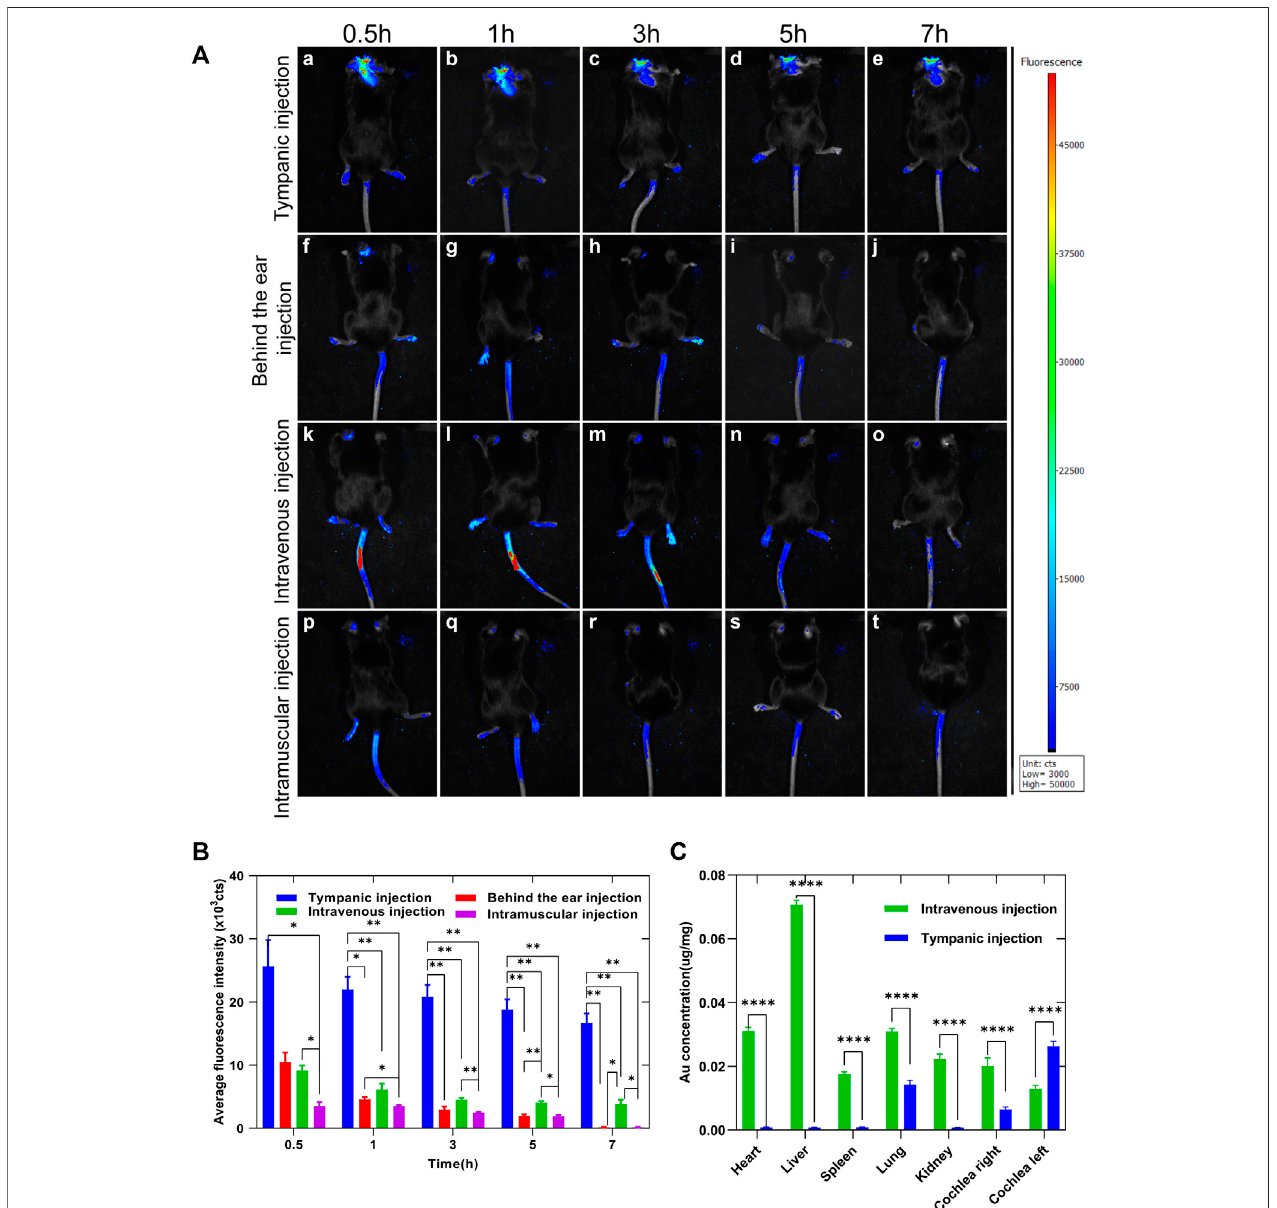
FIGURE 6 | (A) Enrichment of Au-DENPs in the cochlea by different injection methods after 0.5, 1, 3, 5, and 7 h using a small animal imaging system. (B) Quantitative fl uorescence of temporal bone after injection in tympanum, posterior auricular sulcus, vein, and muscle. (C) Gold content in the main organs after 5 h of tympanum and intravenous injection of Au-DENPs (2 mg/kg) with ICP-AES.* p < 0.05, ** p < 0.01, *** p < 0.001, and **** p < 0.0001.